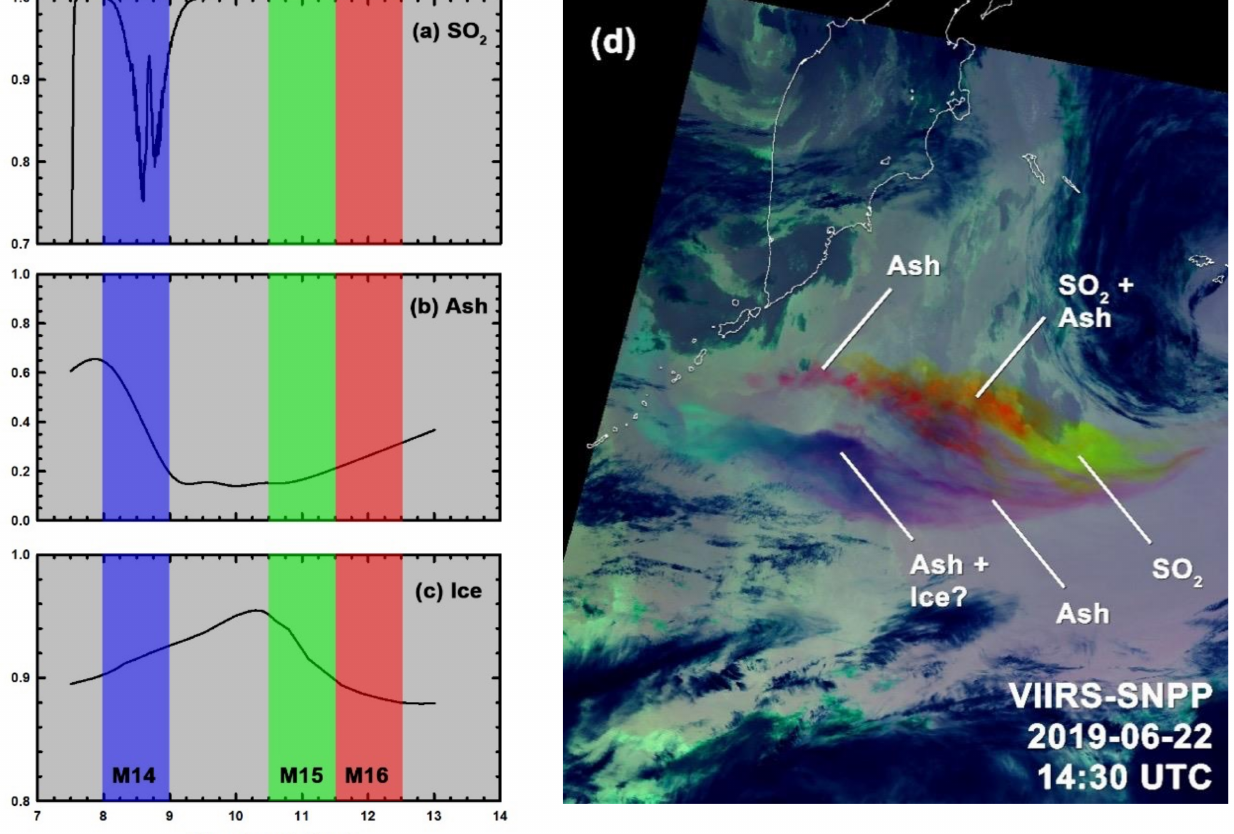
Figure 3. Distinctive features in the TIR spectra of ( a ) SO 2 , ( b ) silicate ash, and ( c ) ice crystals allow us to discriminate volcanic SO 2 and ash ( d ) from icy meteorological clouds. The color composite of data from the VIIRS TIR channels ( d ) shows the distributions of SO 2 , ash, and ice crystals in the Raikoke eruption clouds at 14:30 UTC on 22 June